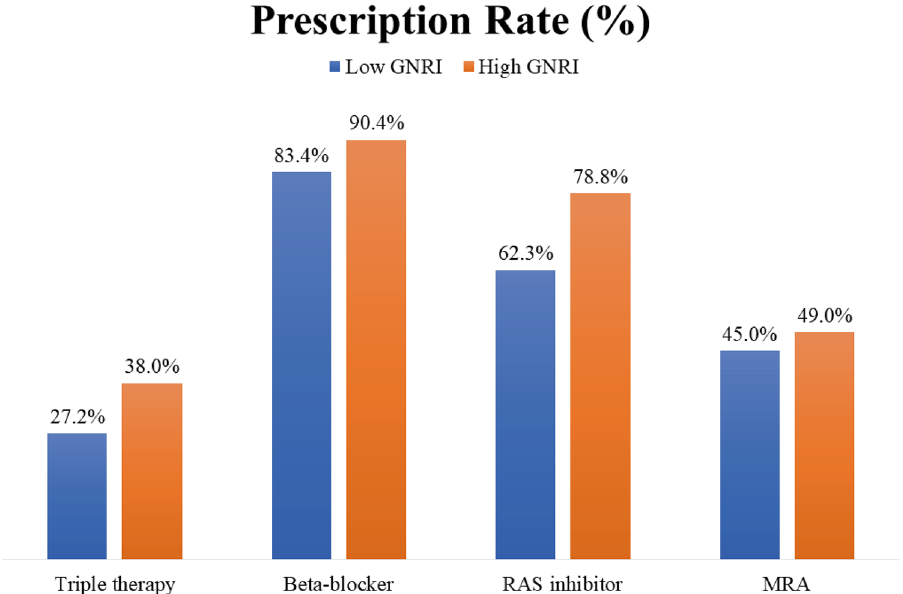
Figure 3. Prescription rate of each agent according to Geriatric Nutritional Risk Index: Low GNRI for moderate or severe nutritional risk with GNRI < 92, and high GNRI for low or no nutritional risk with GNRI ≥ 92. GNRI geriatric nutritional risk index, RASi renin-angiotensin-system inhibitor, MRA mineralocorticoid receptor antagonist, GNRI geriatric nutritional risk index, ACEi angiotensin-converting enzyme inhibitor, ARB angiotensin receptor blocker, MRA mineralocorticoid receptor